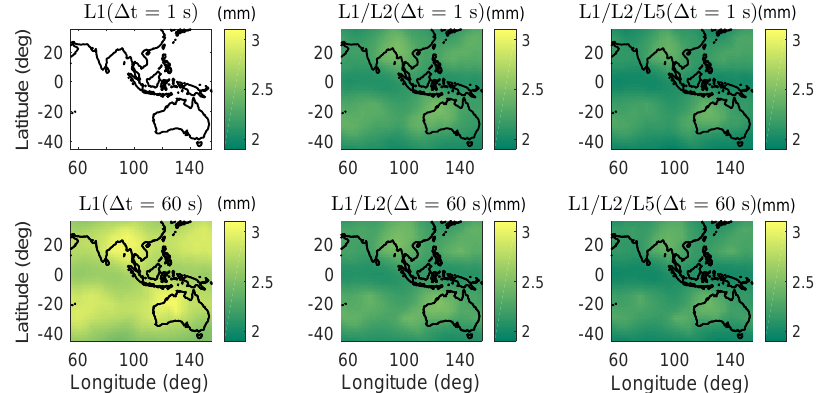
Figure 18. Square roots of the stationary values of the gain numbers ( a , Equation (19)) and the corresponding gain vectors f 3 in the horizontal plane ( b ). Data of baseline CUAA-CUBB is used for the L1-only case. The time span between the two epochs is 1 s.